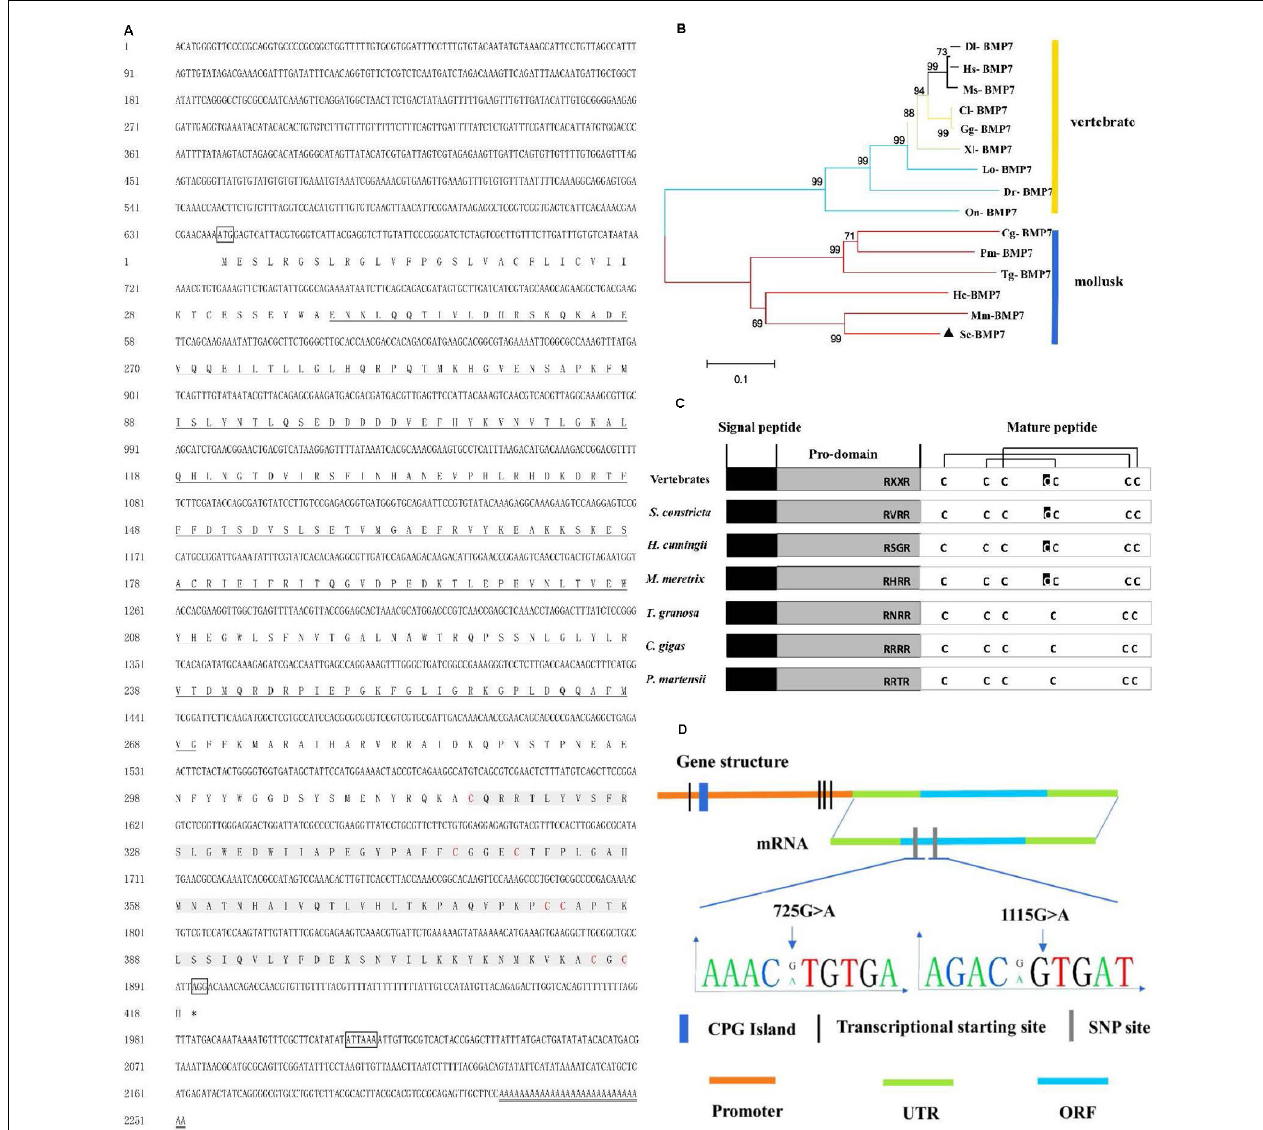
FIGURE 1 | Analysis of sequence and structure of Sc-BMP 7 gene. (A) The full-length cDNA and deduced amino acid sequence of Sc-BMP7. The letters boxes are the start codon, the stop codon and the polyadenylation signal sequence, the ∗ represents the end of the protein translation, the double line is the poly A. the bold underlined parts are the propeptide, shaded gray part is the signal peptide, red letters are cysteine residues. (B) Neighbor-joining phylogenetic tree of BMP7 between S. constricta and other species using MEGA6.0 software. The abbreviation of BMP7 and the GenBank accession numbers used to construct phylogenetic tree are given in Table 2 . (C) Structure of Sc-BMP7 and selected BMP7 genes from mollusks and vertebrates. (D) Gene structure of Sc-BMP7